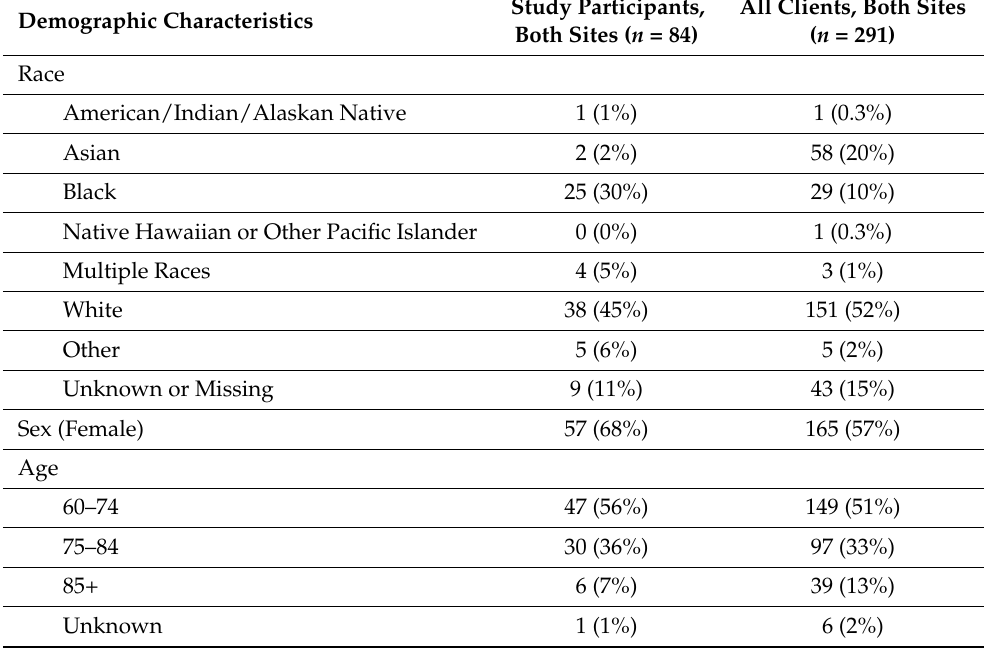
Table 2. Study participant and target population